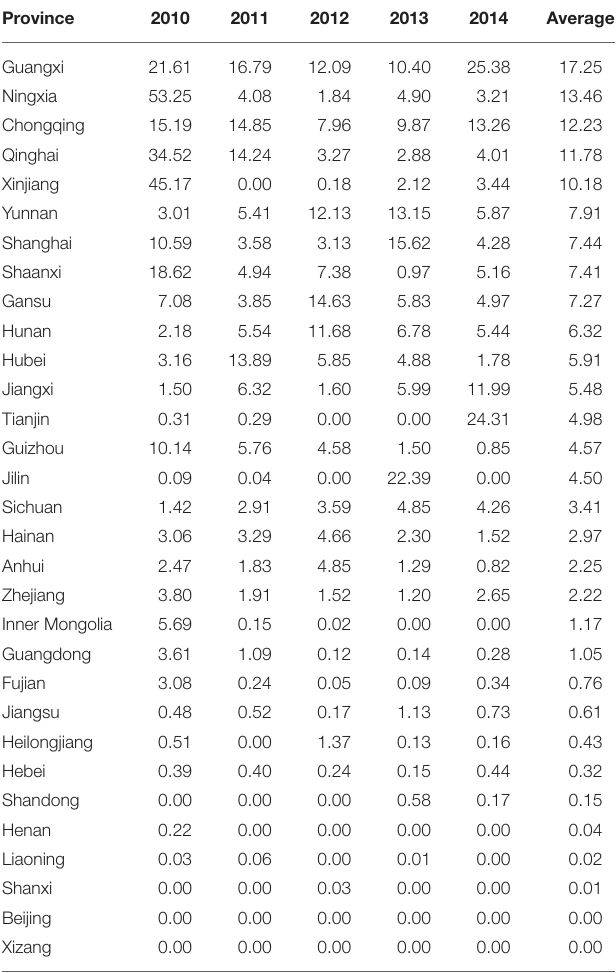
TABLE 1 | Epidemic index of animal disease in various provinces (2010–2014).